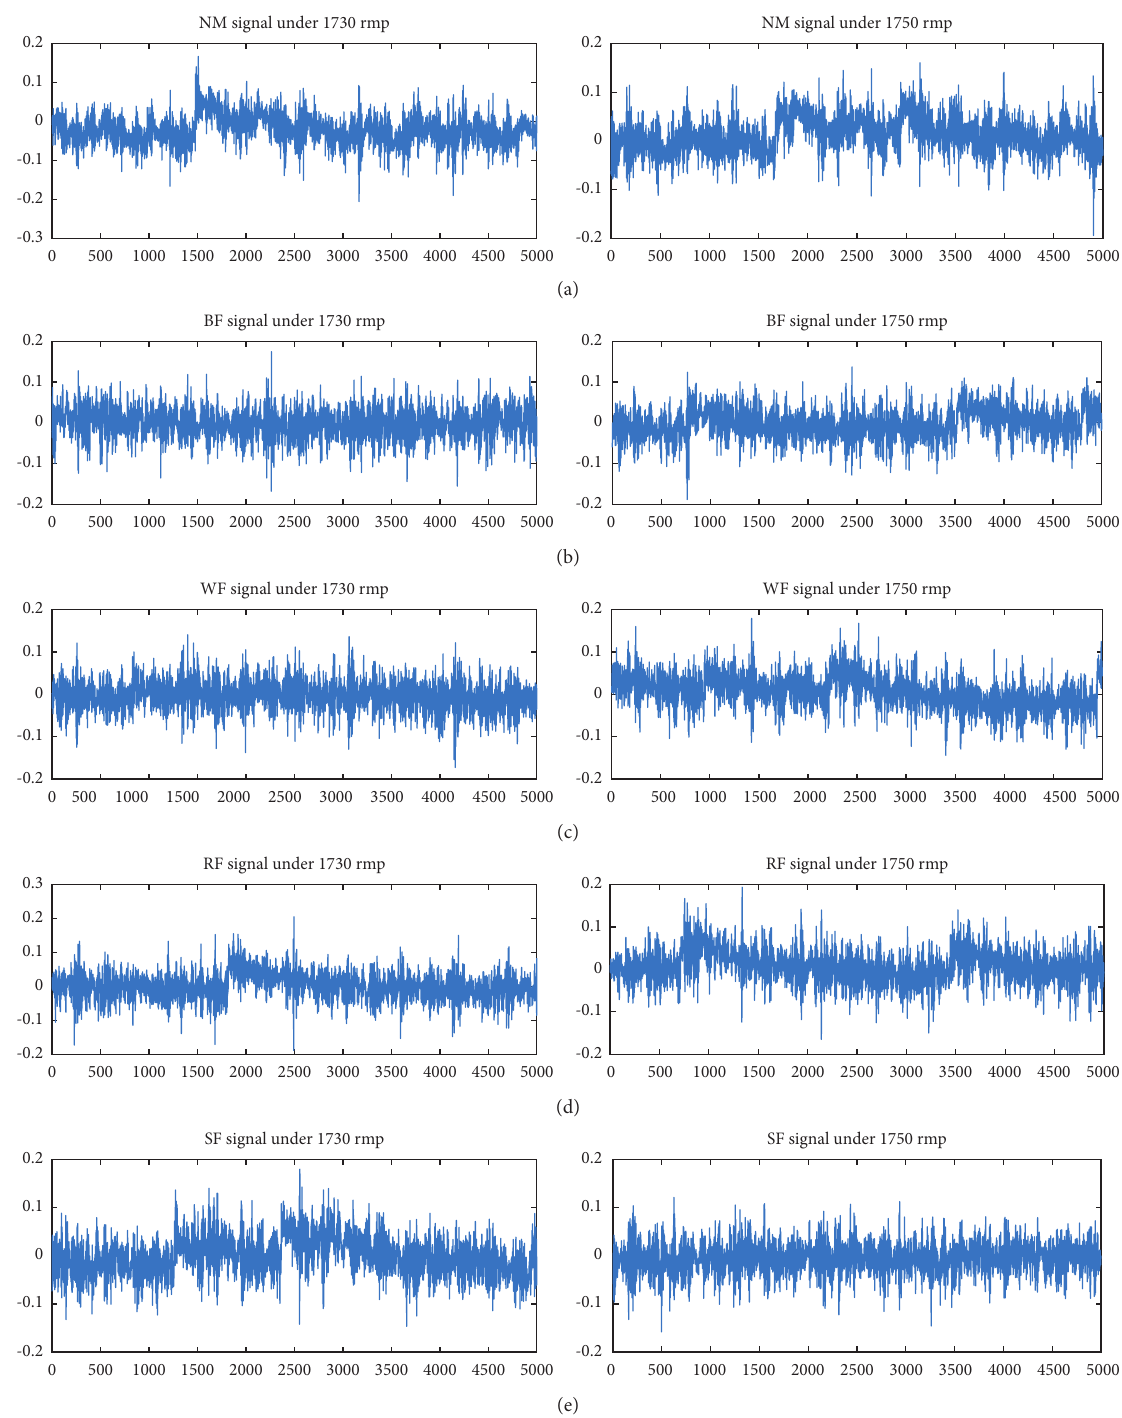
Figure 8: Raw signals of the 5 kinds of motor conditions. (a) Raw signal under normal state. (b) Raw signal under broken rotor bar fault. (c) Raw signal under winding fault. (d) Raw signal under rotor bowed fault. (e) Raw signal under single phase voltage unbalance